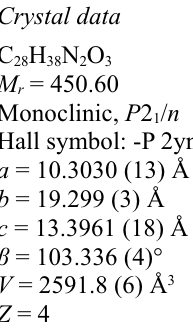
The molecular structure of (I), showing 30% probability displacement ellipsoids. H atoms have been omitted for clarity. 10-[2-(Dimethylamino)ethyl]-9-(4-methoxyphenyl)-3,3,6,6-tetramethyl- 3,4,6,7,9,10- hexahydroacridine-1,8(2 H ,5 H